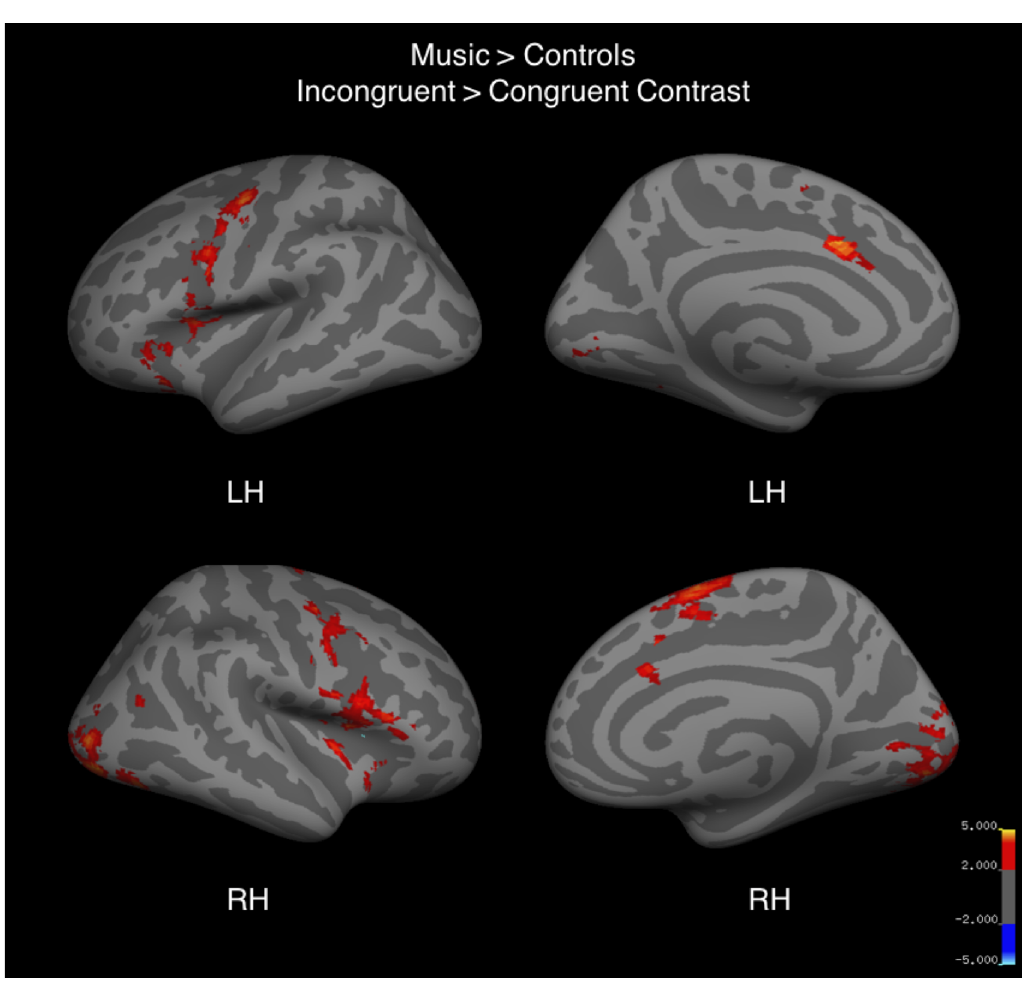
Fig 5. Whole brain activation for incongruent > congruent trials of the fMRI Color-Word Stroop task in a two- sample comparison of music group greater than control group. Red to yellow corresponds to positive z-values. Images are cluster thresholded at Z > 2.3 and cluster size threshold of p <